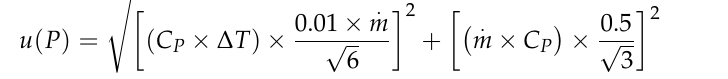
connected under test conditions ( right-hand side ).